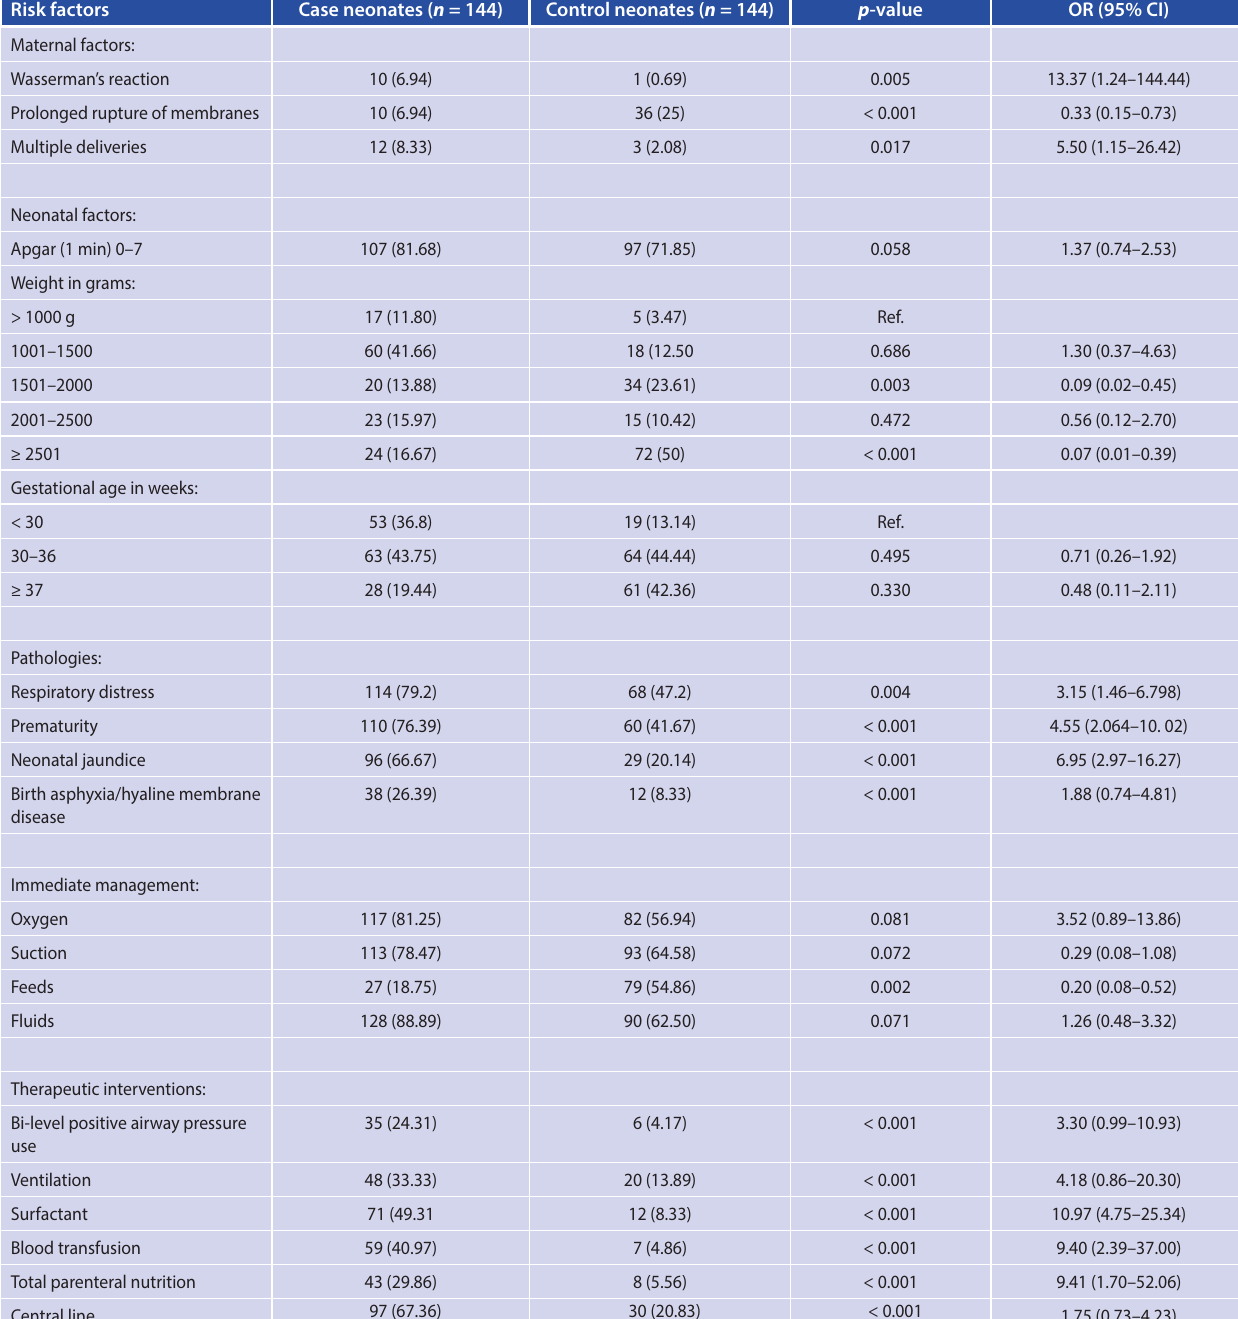
Table 4: Multivariable analysis of the risk factors associated with nosocomial infections in the NICU at MGMH from 2014 to 2015 ( n =